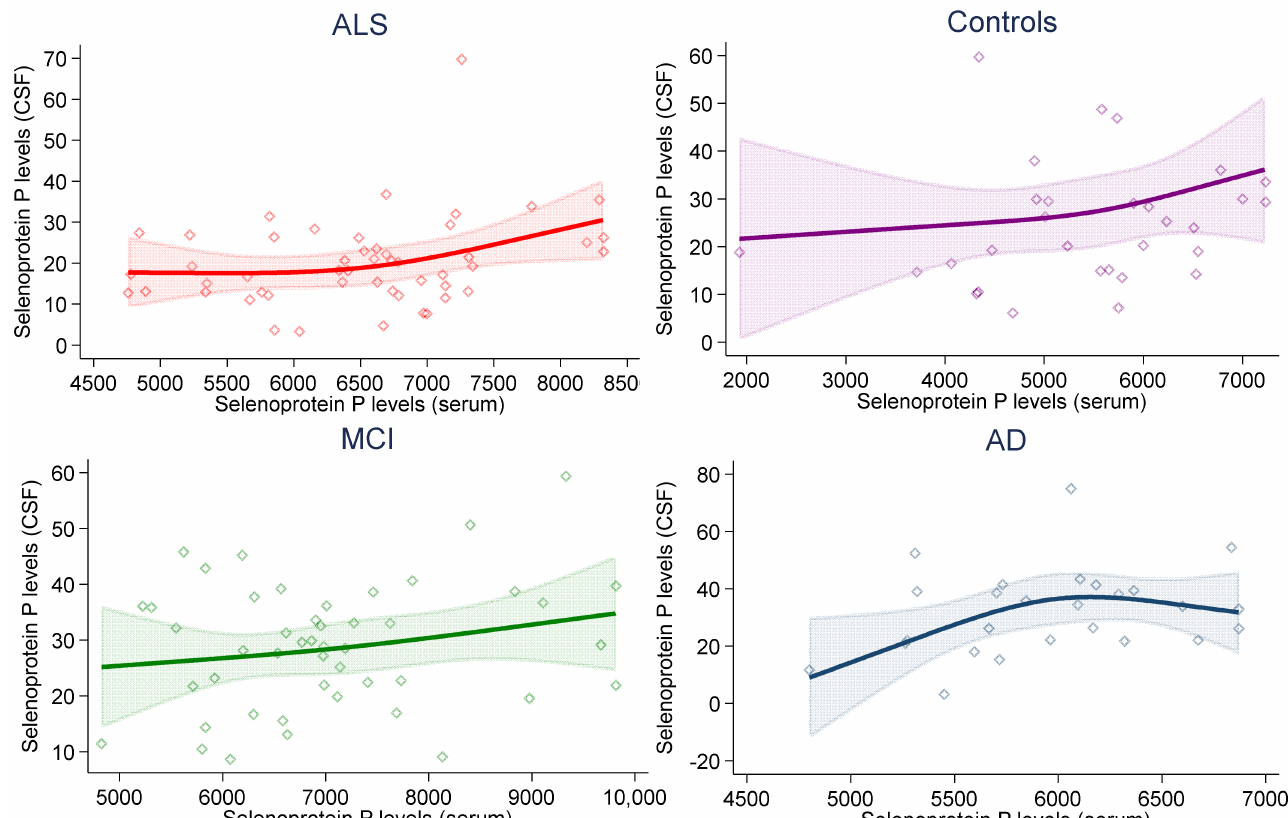
Figure 1. Association between serum and cerebrospinal fluid (CSF) selenoprotein P levels (ng/mL) in study subgroups in multivariable (age- and sex-adjusted) spline regression analysis, with 95% confidence